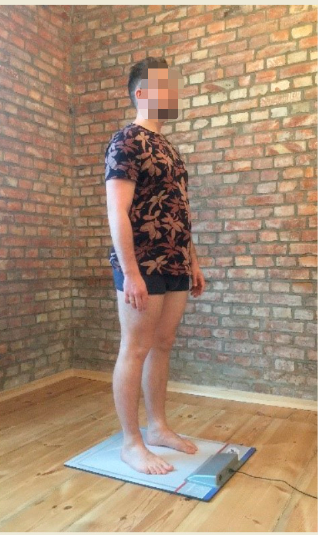
Figure 2. Evaluation using a stabilometric platform. Author’s content.